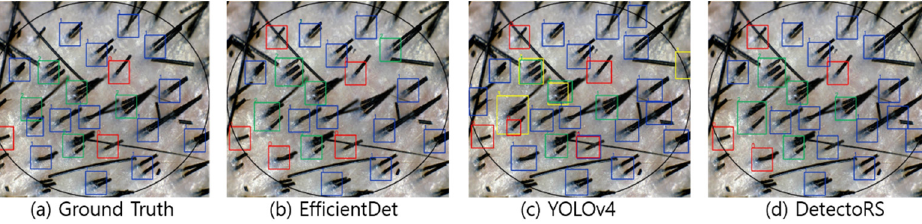
Figure 7. Visualization of detection results in an image with a large number of short and long hairs.